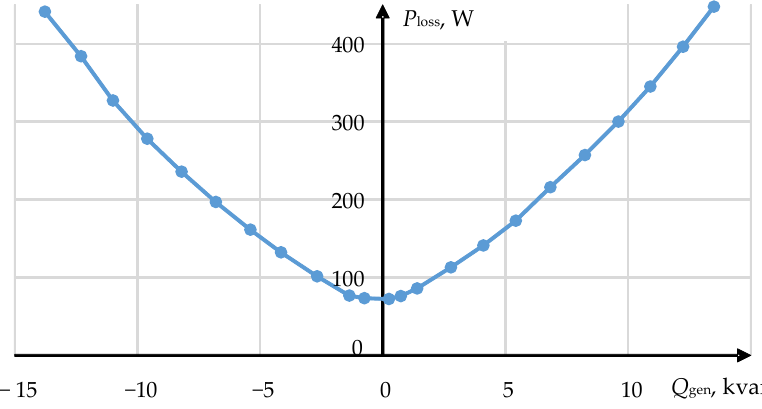
Figure 8. Power losses measured during the reactive power generation mode.